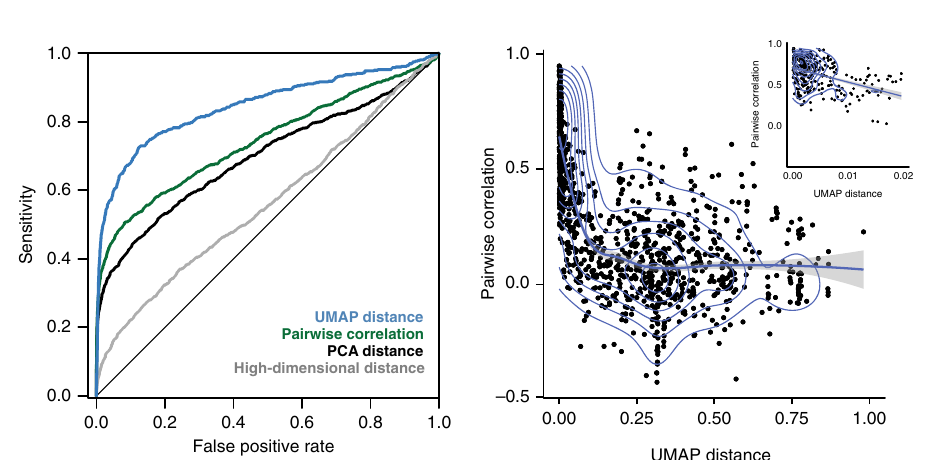
Fig. 1 UMAP clusters single-gene deletion transcriptomes according to shared function. a UMAP coordinates of 1484 single-gene deletion strains clustered by similarity in transcriptional effects. The initial 50 individual clusters are each shown in a different color. Strains that comprise protein complexes are indicated alongside a bar colored according to cluster identity. Each complex is represented as a fraction: the number of complex members found in the cluster over the number of complex members in the set of 1484 mutants. Clusters with coordinates far from the main group are shown in boxes. Clusters without a known complex are marked as “ unknown, ” along with an arbitrary cluster number; these clusters are annotated with a broad GO term enriched in that cluster. b Cluster 2 shows more distinct groupings when re-clustered separately. Annotations as in a . Cluster 2 as a whole was enriched for cell cycle and chromosome organization, with individual clusters corresponding to parts of this process. c The tRNA wobble uridine pathway, captured entirely within the cluster containing the Elongator complex (boxed green cluster in a ). Complex members within this cluster are annotated with orange boxes, while new members are annotated in blue. One pathway member, Nfs1, was not present in the single-gene deletion dataset. The heatmap represents fi ne-scale distances between each pair of points within the cluster. Darker shades of red indicate points nearer in UMAP space; hierarchical clustering was applied on this distance metric to group proteins within this pathway. Heterodimeric interactions, such as Ncs6-Ncs2 (bottom-right corner of heatmap), are nearer to each other than other members of the pathway. Novel members of this pathway (blue text) are grouped with other members based on their similarity of UMAP distance, and these new interactions are indicated with gray lines in the pathway diagram.